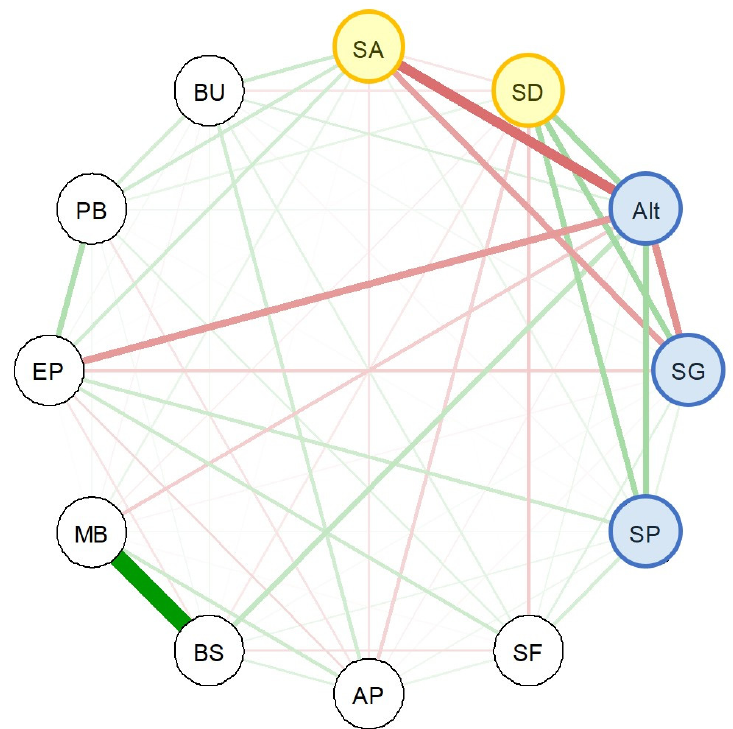
Figure 3. Partial correlation network among the tree quality characteristics, stand characteristics, and site characteristics. The green and red lines indicate positive and negative correlations, respectively. The line thickness indicates the strength of the partial correlation. Yellow, blue, and white circles indicate the stand characteristics, site characteristics, and tree quality characteristics, respectively. Stand age (SA); stand density (SD); altitude (Alt); slope gradient (SG); slope position (SP); stem form (SF); axis persistence (AP); branch size (BS); mode of branching (MB); epicormic shoots (EP); protuberant buds (PB); buttressing